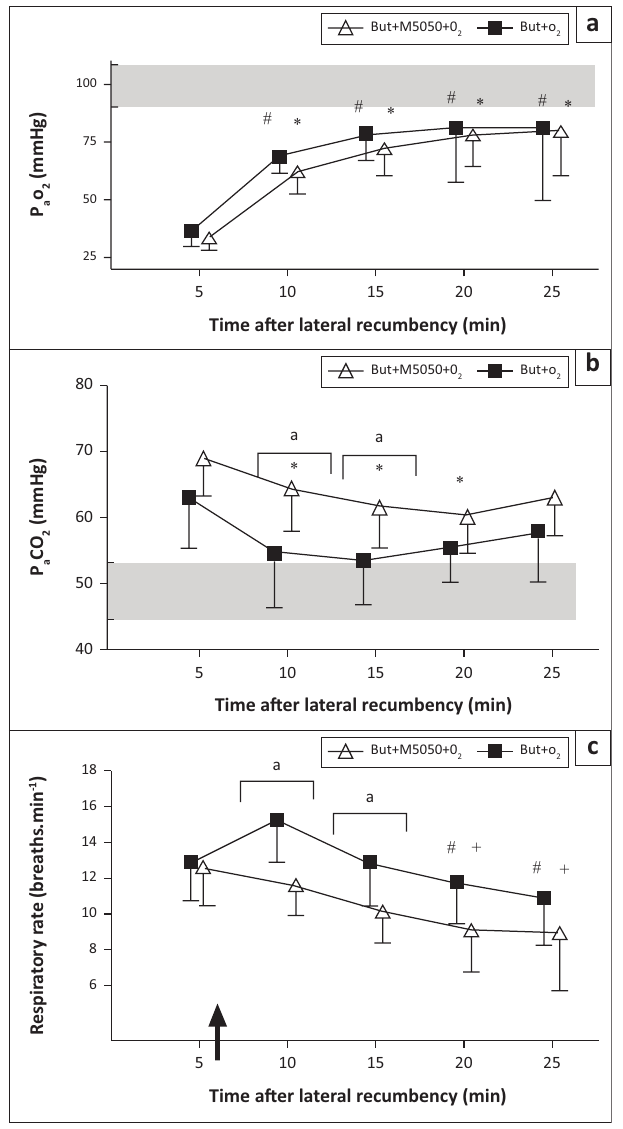
The black arrow indicates the time at which the partial antagonists were administered and oxygen insufflation initiated. Note: ‘a’, indicates the time points at which the values in the But+O group differed from 2 those in the But+M5050+O group. 2 The shaded area represents the range of normal values in standing, unrestrained white rhinoceros. * , Values in the But+O trial that differ from pre-intervention values (5 min). 2 + , Values in the But+O trial that differ from values at 10 min. 2 # , Values in the But+M5050+O trial that differ from pre-intervention values (5 min). 2 Source : Citino, S.B. & Bush, M., 2007 ‘Reference cardiopulmonary physiologic parameters for standing, unrestrained white rhinoceroses ( Ceratotherium simum )’, Journal of Zoo and Wildlife Medicine 38, 375–379. https://doi.org/10.1638/2006-0007R1.1 FIGURE 3: Field study. (a) Partial pressure of arterial oxygen (P O ), (b) partial a 2 pressure of arterial carbon dioxide (P CO ) and (c) respiratory rate of field- a 2 immobilised rhinoceros given intravenous butorphanol + oxygen insufflation (But+O , n = 14) or intravenous butorphanol + diprenorphine + oxygen 2 insufflation (But+M5050+O , n = 8). Mean and standard deviations 2